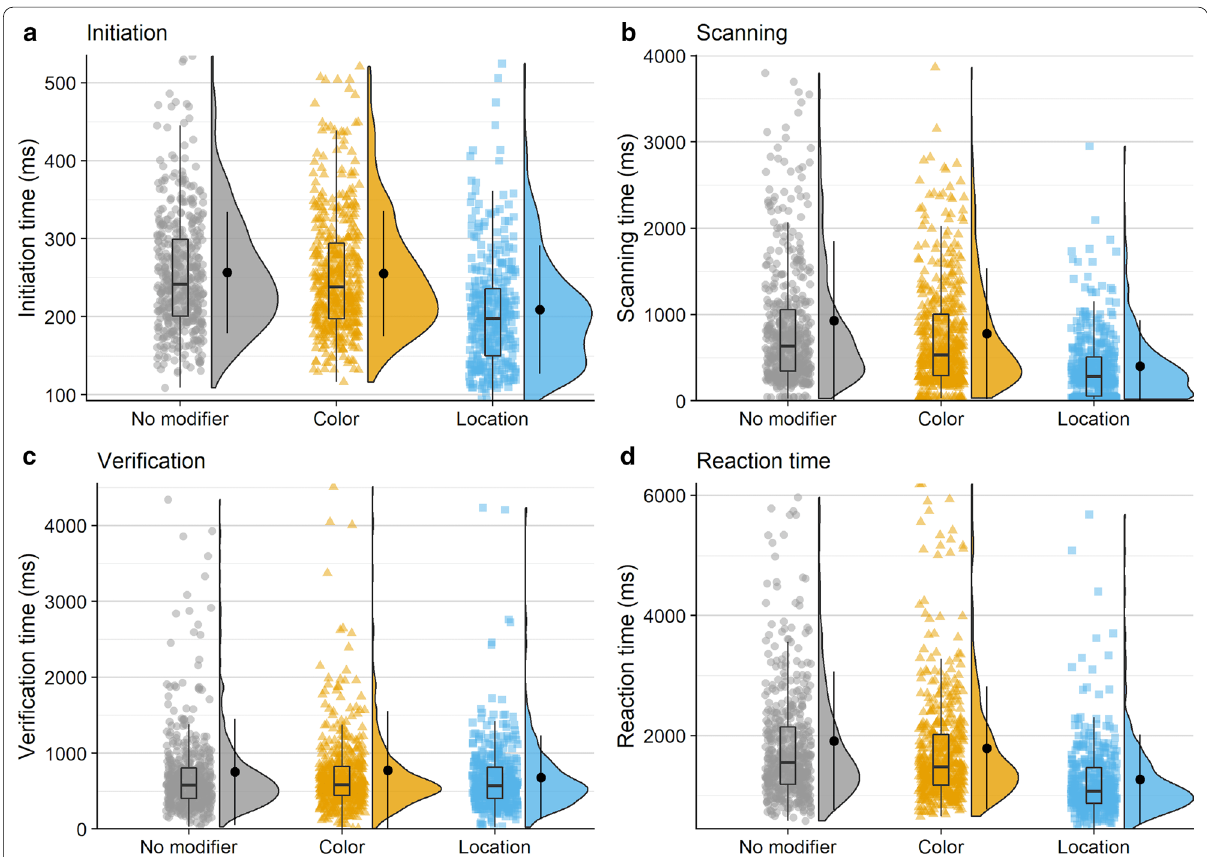
Fig. 3 Raincloud plots depicting data for Experiment 1, oriented vertically for legibility. Points on the left side of each raincloud show raw data. Box plots, superimposed over the raw data, indicate the median value (middle horizontal line), the first and third quartiles (top and bottom lines in box), and 1.5 the interquartile range: the distance between the first and third quartiles (whiskers). Violin plots show the range (minimum and × maximum) and density (width) of the data. Isolated points on the right side of each raincloud indicate the mean, and error bars on said points reflect one standard deviation. For ease of visualization, the bottom 99% of the data are shown